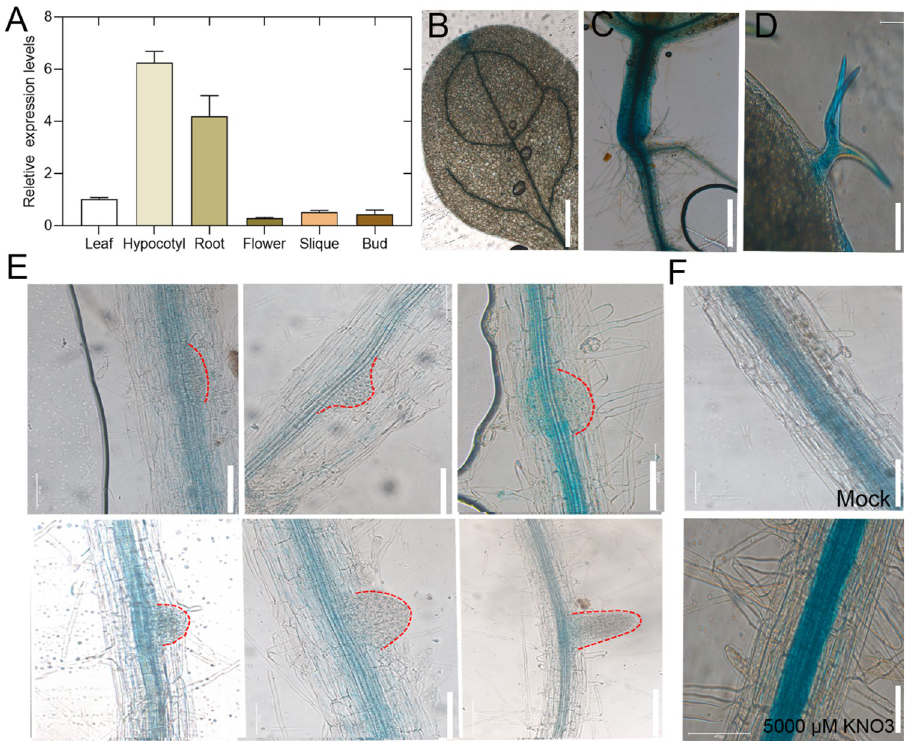
Fig 3. Analysis of proNAC056::GUS transgenic lines during LR development. A. Relative NAC056 expression level in young fully expanded leaf, root, hypocotyl, silique, flower, or flower bud. Three independent replicate experiments were conducted. Values are given as mean ± standard error (SE), n = 3. (B-D). GUS staining in proNAC056::GUS Arabidopsis leaf, root, hypocotyl and trichrome. E. GUS staining in proNAC056::GUS Arabidopsis LRs at various developmental stages. F. The seedlings were grown on medium supplemented with 5,000 μ M KNO 3 for 4 h. Images of the GUS signals in roots were obtained, and representative images are shown. The white bar indicates 50 μ m.